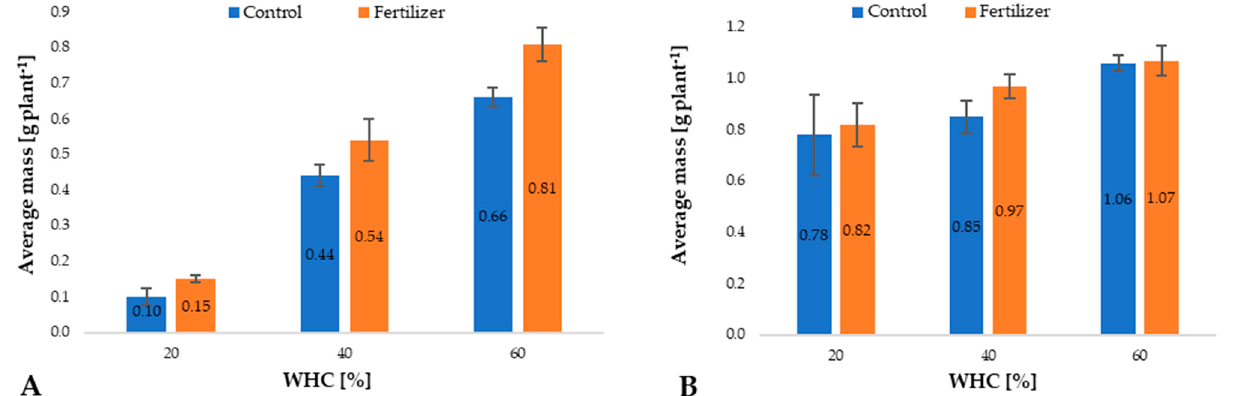
Figure 1. Mass of the above ground ( A ) and underground ( B ) parts of the maize plant in relation to whether or not fertilizer was applied and to WHC [%] ( n = 500): differences between the results for enhanced and non-enhanced plants growing in soils with the specific water holding capacity are marked with small letters, and differences in the results for the various water holding capacity values are marked with capital letters. Significance level is defined as p < 0.05.